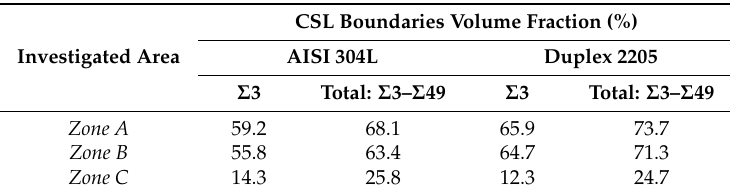
Table 4. CSL boundary fractions parameter in the γ -phase.